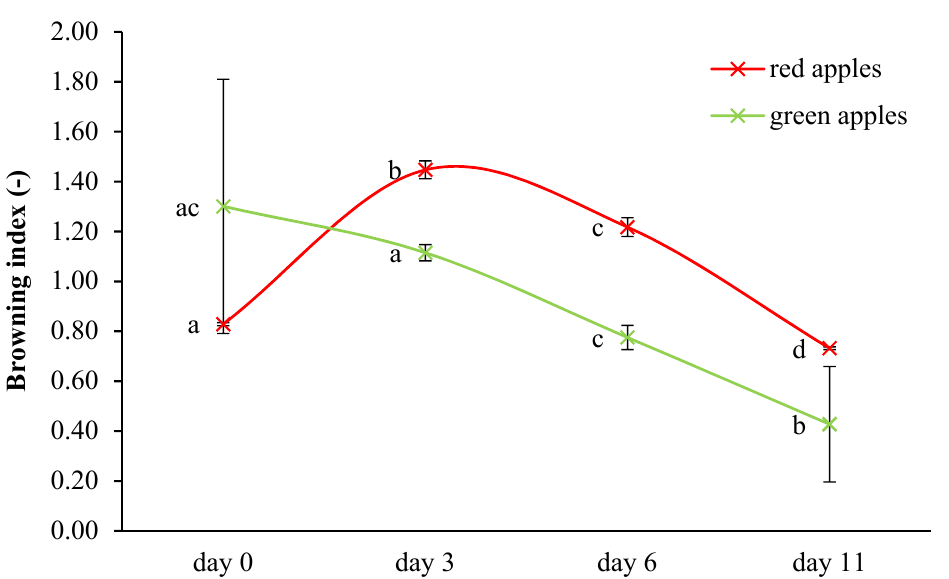
Figure 2. Determination of apples’ browning index (uppercase letters indicate statistically significant differences ( p < 0.05) between red and green apples; lowercase letters indicate significant differences ( p < 0.05) between days of storage).